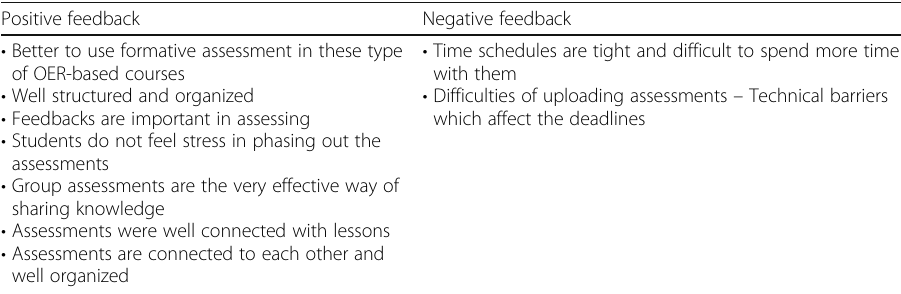
Table 4 Feedback on assessment